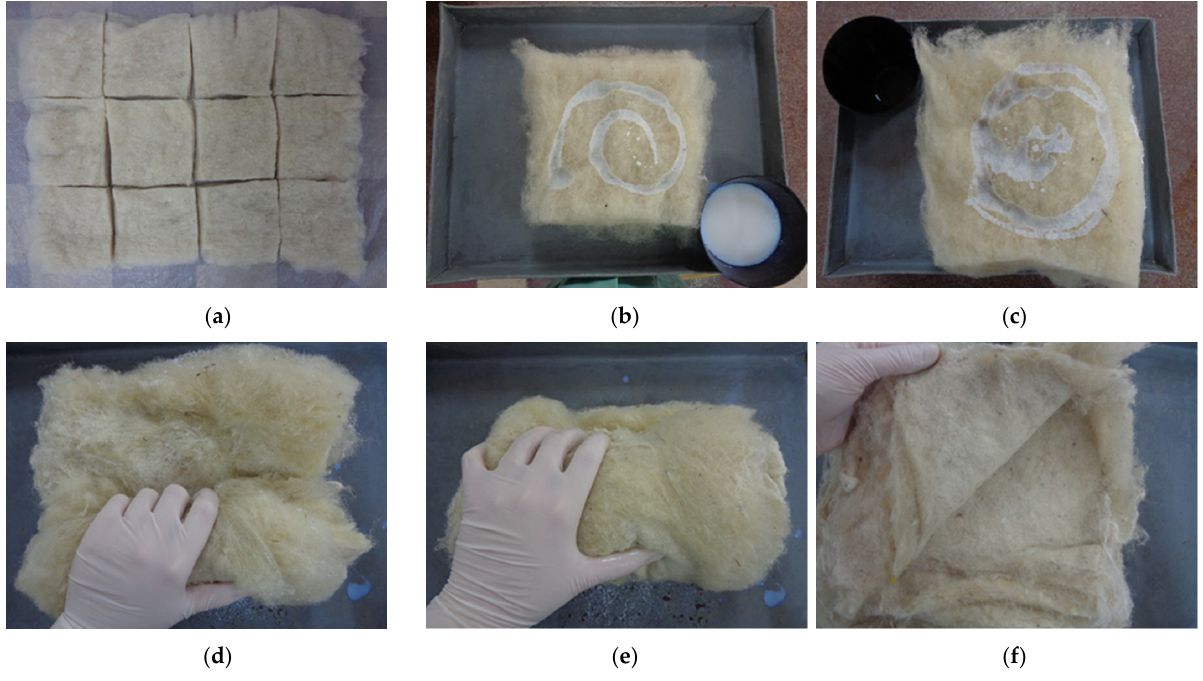
Figure 6. Making the specimens P13-P24 by mixing the binder with fibres: ( a ) fibres cut to size; ( b , c ) sprinkling binder over fibres; ( d , e ) wrapping the fibres-binder assembly; ( f ) resulting layers.